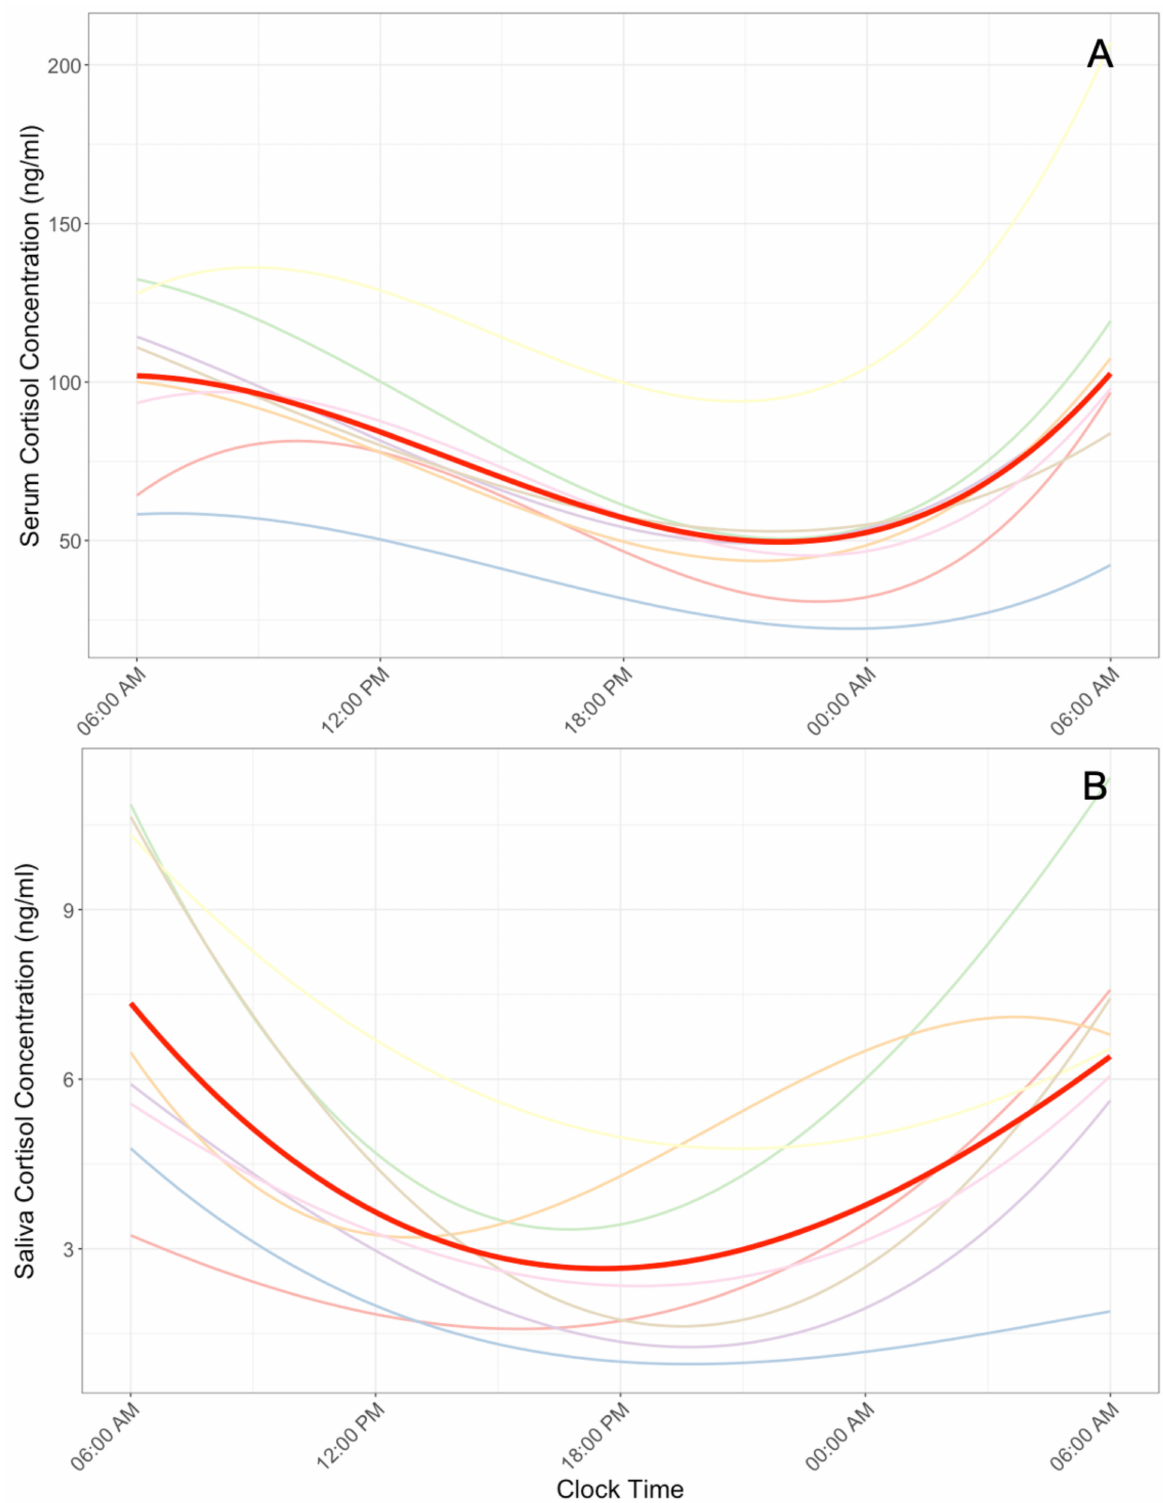
Figure 1. Serum ( A ) and saliva ( B ) cortisol profiles across 24-h. The serum and saliva profiles were best characterized via a cubic and quadratic model, respectively. Mean profiles are depicted in